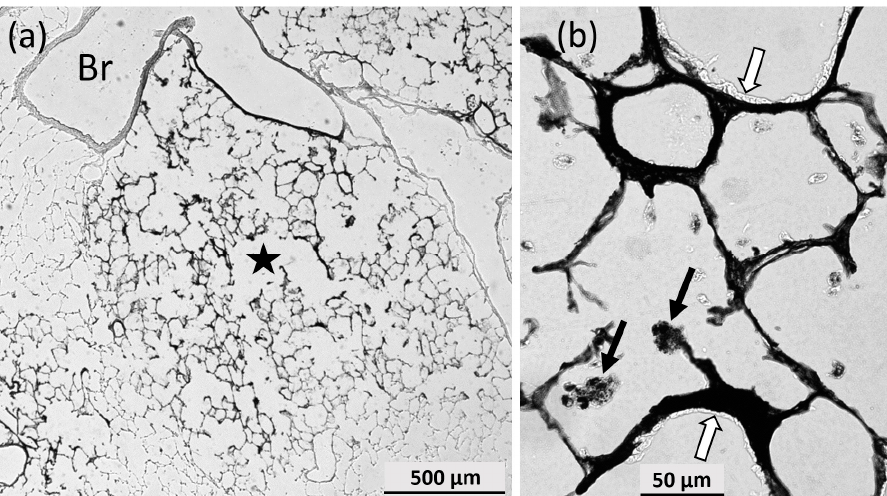
Figure 11. Autometallographic staining of a rat lung instilled with 150 µg Ag50-PVP nanoparticles. ( a ) Representative part of the lung epithelium; the asterisk marks a silver-containing region with black-stained alveolar septa; ( b ) at higher magnification, single alveolar macrophages (arrows) and densely-stained epithelium are visible. Open arrows point to unstained bronchial tissue.